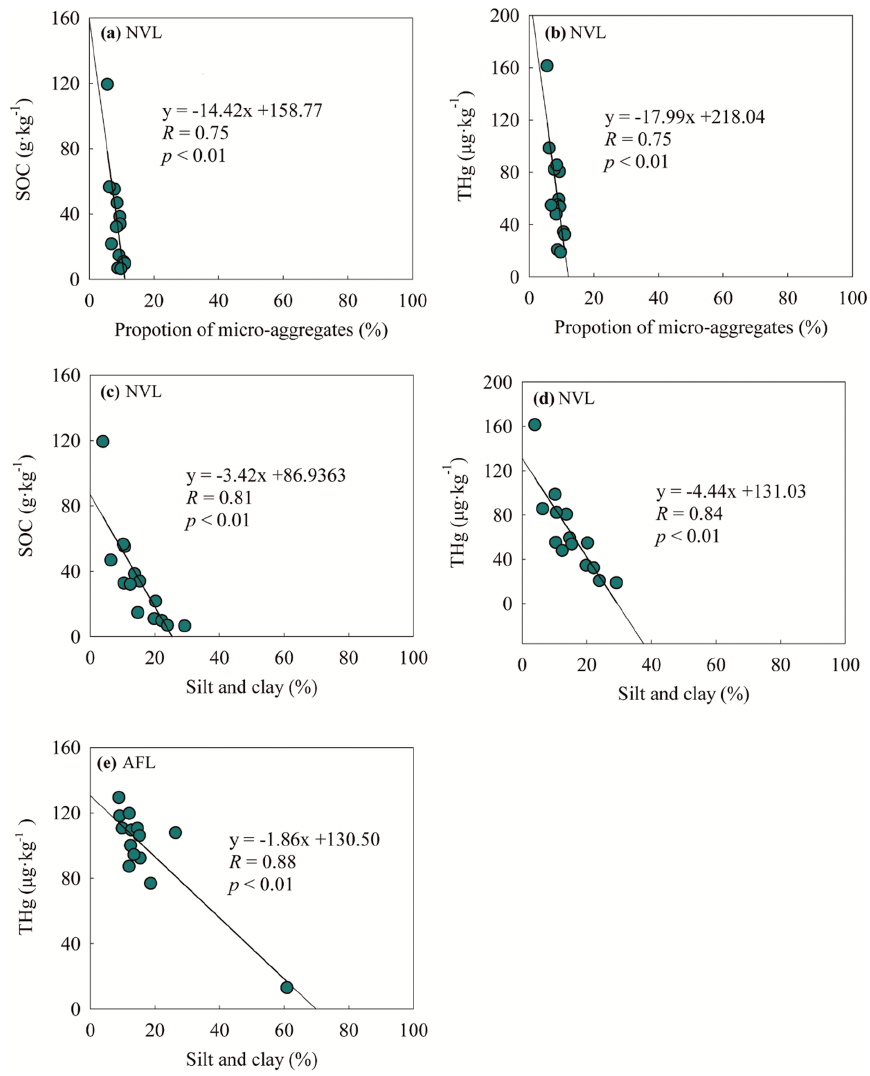
Figure A1. The total mercury concentration distributes with depth under native vegetation land (NVL), farmland (FL), and abandoned farmland (AFL). Land 2020 , 9 , x FOR PEER REVIEW